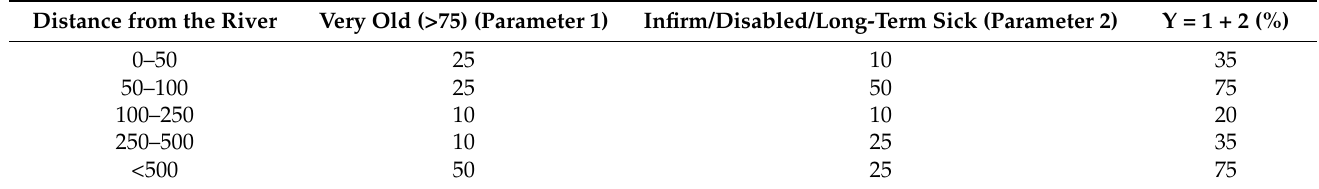
Table 6. Generating the human vulnerability in the Bra´nszczyk commune.